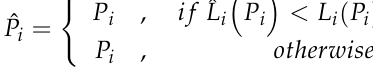
P . Figure 6. The mutual learning process of P 1 1